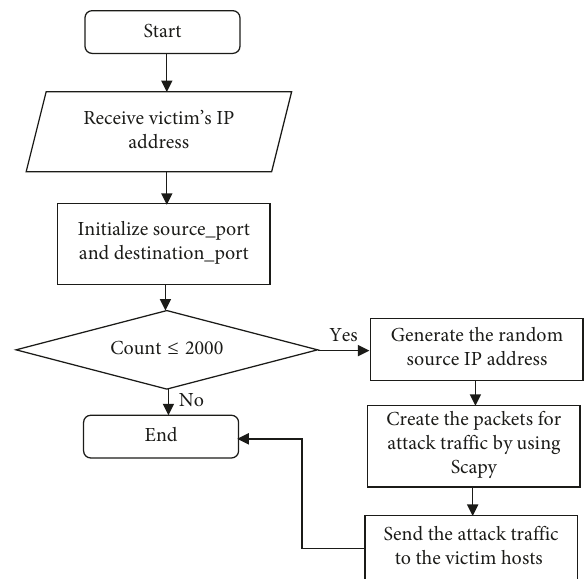
Figure 4: Step by step process of UDP Flooding